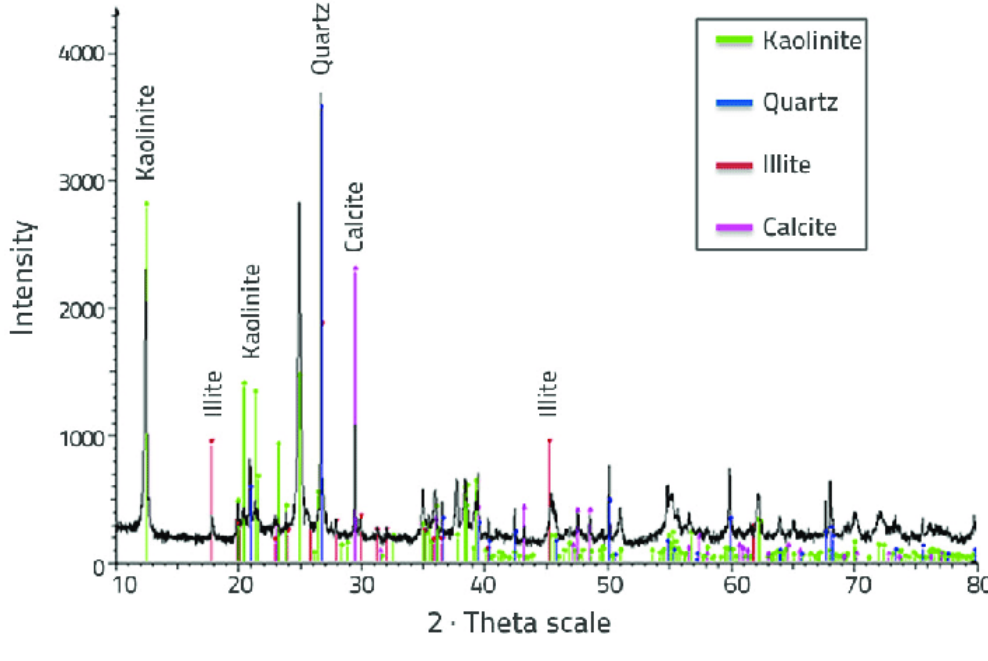
Figure 5: X-ray diffraction of clay sample. (Quartz, Illite, Kaolinite, and